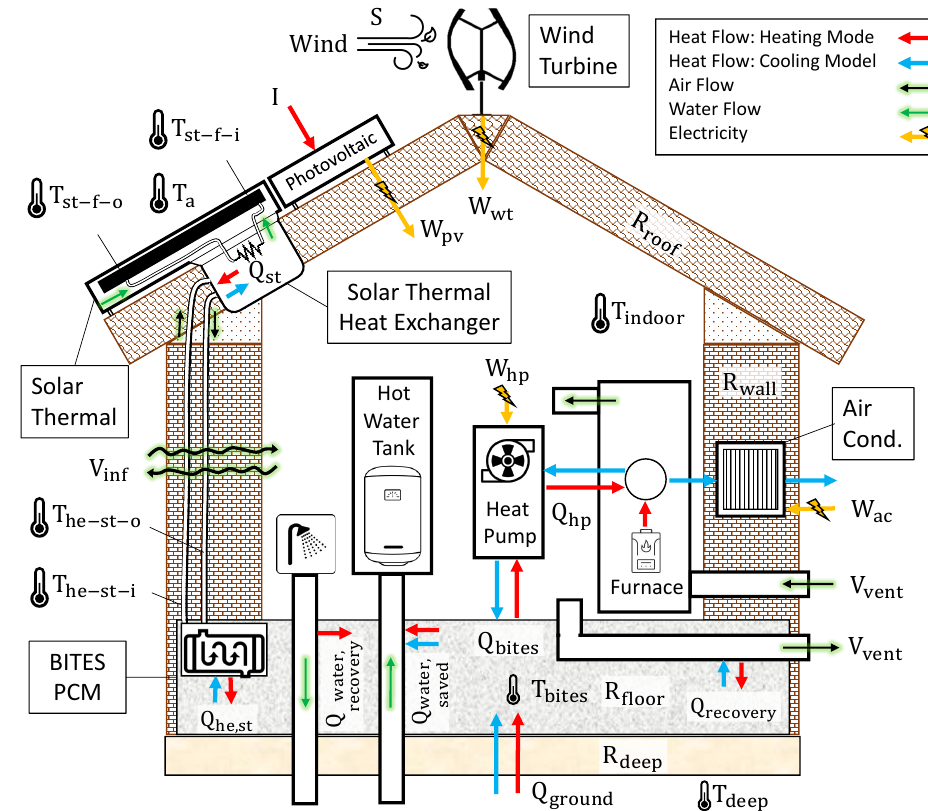
Figure 2. System configuration to reduce building sensible heating/cooling loads and water heating